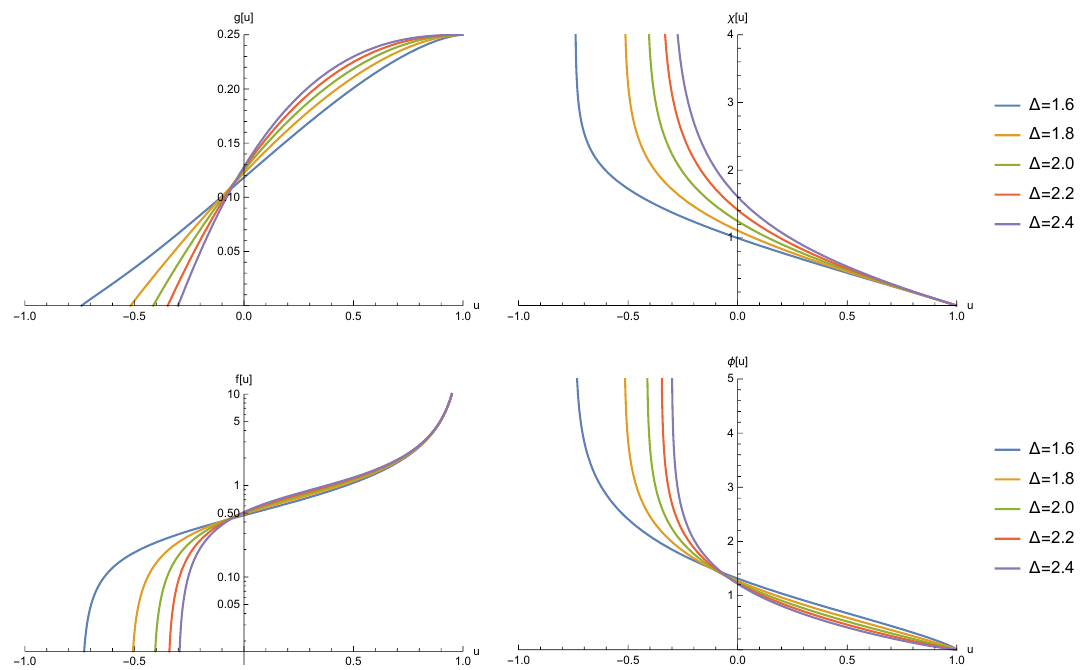
Figure 4 . Numerical plots of singular solutions of g ( u ) , χ ( u ) , f ( u ) and φ ( u ) with ∆ = ∆ + for various dimensions in the range of 1 . 6 ≤ ∆ 2 . 4 . Here we have Log plot for f ( u ) and choose the + ≤ parameter α = 2 . 0